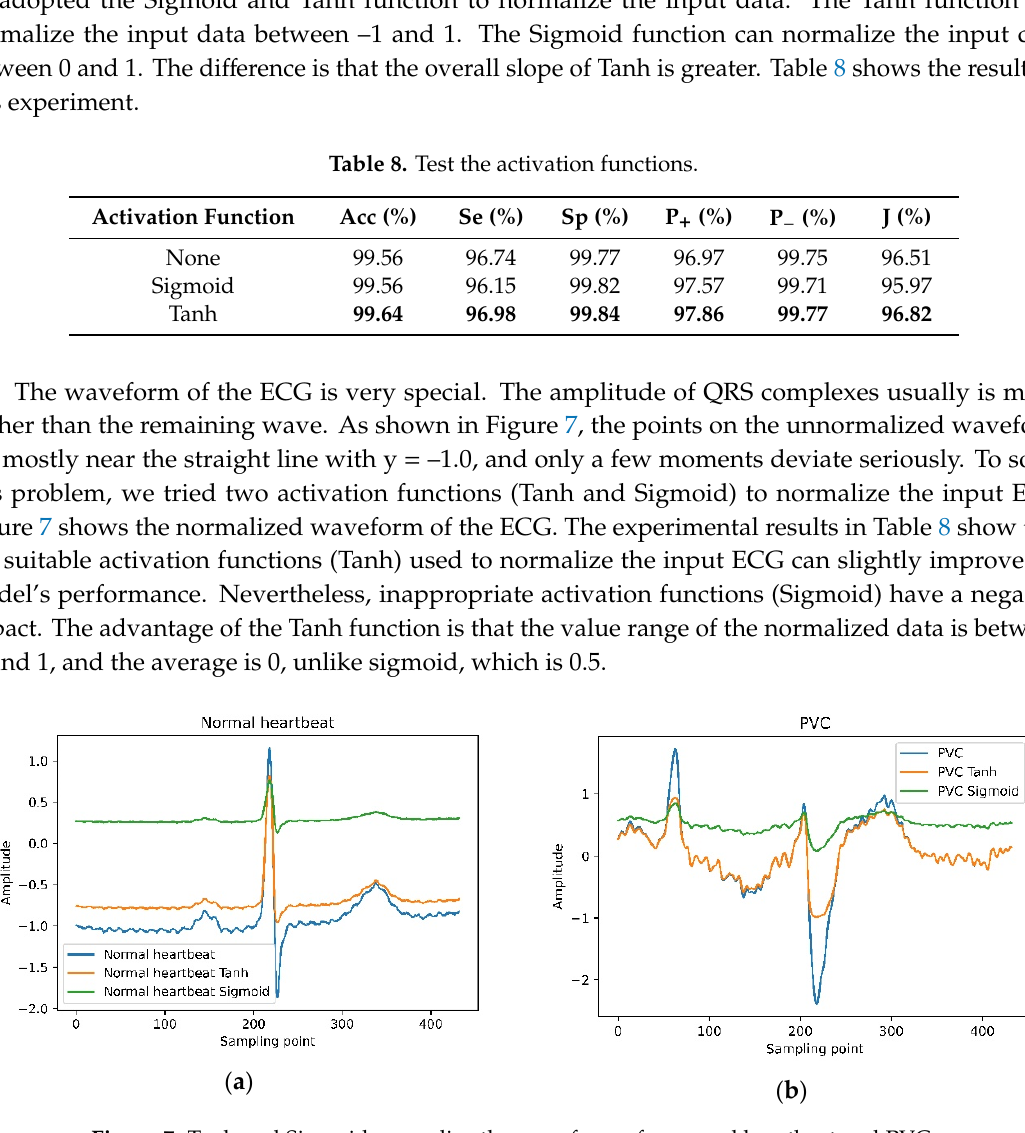
Table 9. Employ the proposed model with Scheme 2 and Scheme 3.